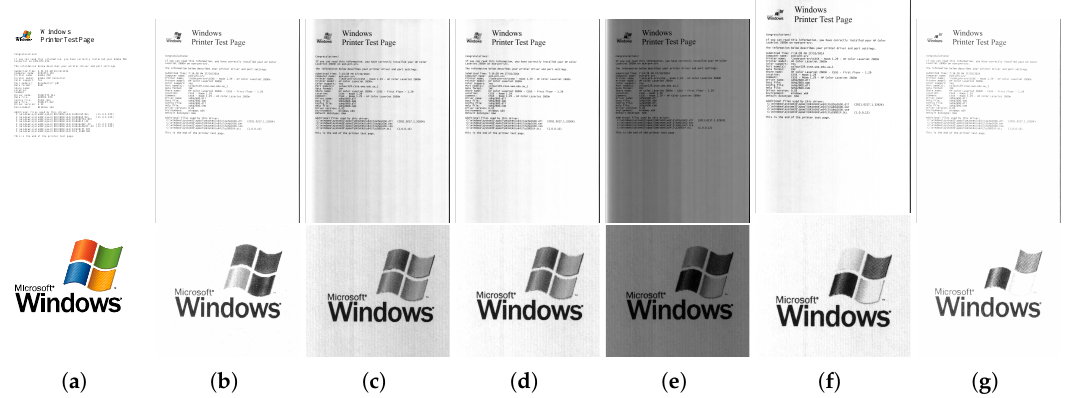
Figure 9. The printed test document ( top ) and a magnified view of the logo contained within ( bottom ) in: ( a ) true RGB; ( b ) royal blue; ( c ) cyan; ( d ) green; ( e ) amber; ( f ) red orange; and ( g ) deep red